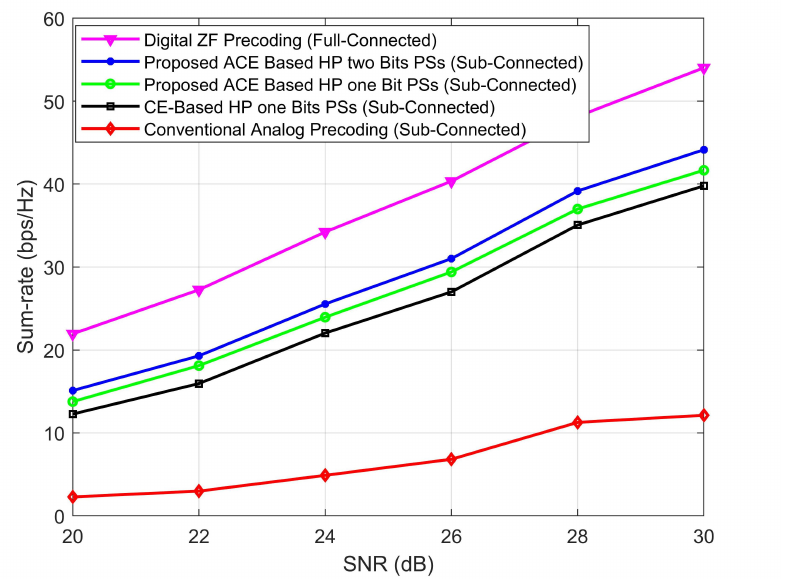
Figure 4. Sum rates of ACE-based method with sub-connected PSs when C = A = 12 and user count and RF chain are